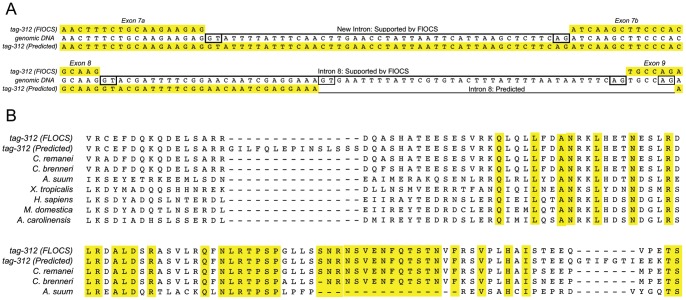
Full-length ORF sequence of tag-312 (Rab45) isolates reveals a different splice pattern than predicted.A) A nucleotide alignment of tag-312 (FlOCS), genomic DNA and the predicted tag-312 ORF at two regions where exon/intron splice junction differences were found. In the top alignment, FlOCS reveals a new intron, splitting predicted exon 7 into exons7a and 7b. In the bottom alignment, FlOCS reveals an alternate 5′ splice donor and 3′ splice acceptor for intron 8. Compare FlOCS-supported 5′ and 3′ splice sites boxed in bold to predicted 5′ and 3′ splices sites (boxed, not bold). B) Two multiple sequence alignments of Rab45 subfamily members spanning the two regions described in 5A above demonstrate the impact of FLOCS-supported gene structure differences. The alignment includes proteins from the nematodes, Caenhorabditis elegans, tag-312(FlOCS) and NP508523.1, Caenhorabditis brenneri, Caenhorabditis remanei and Ascaris suum in addition to Xenopus laevis (frog), Homo sapiens (human), Monodelphis domestica (opossum) and Anolis carolinensis (lizard). The intron that splits exon 7 into two creates a 15 amino acid deletion that is conserved among all species examined (top). The alternate intron 8 creates an Indel in a region of Rab45 that is conserved among nematodes only.